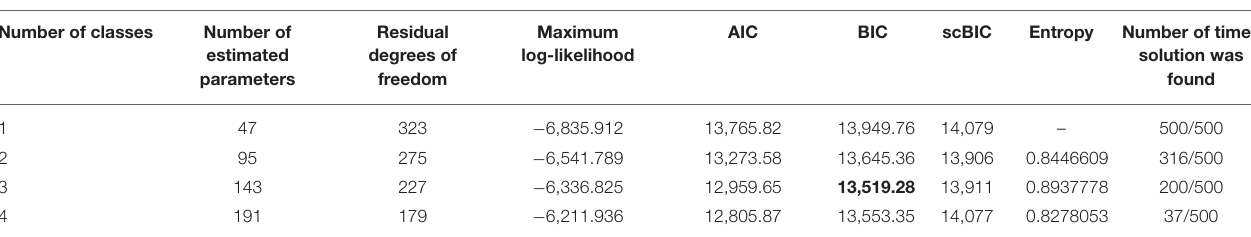
TABLE 2 | LCA model fit evaluation